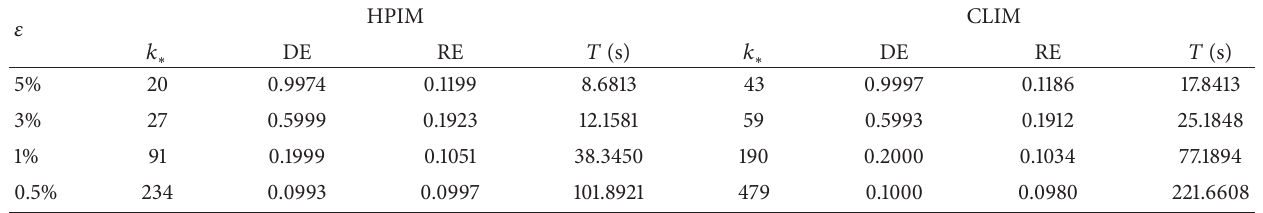
Figure 5: Reconstruction results with HPIM (see (a)) and CLIM (see (b)) for the third phantom at different iteration number, as well as convergence behavior (see (c)). (c) Left: discrepancy error; right: relative error. In both plots, the horizontal axes denote the time of the iteration process. Table 2: Comparison of reconstructions for the second phantom with 𝜏 = 20 at four different noise